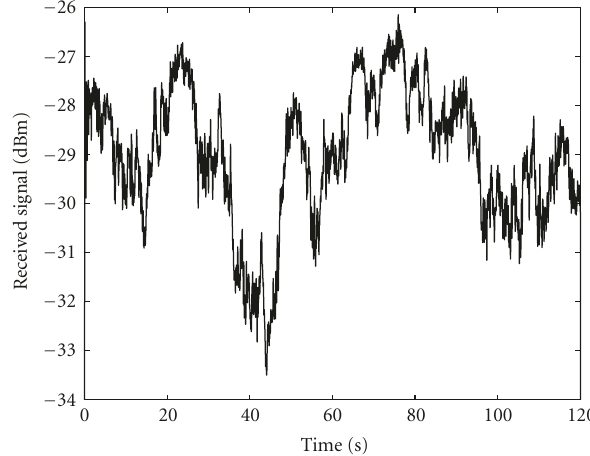
Figure 9: Simulated signal fading using the new model at 29 GHz during low wind speed conditions ( w m = 2 m/s). All simulation parameters are given in Table